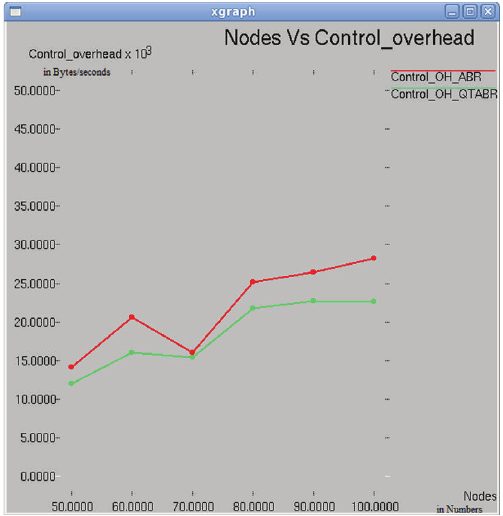
Figure 13: Number of nodes versus control overhead.